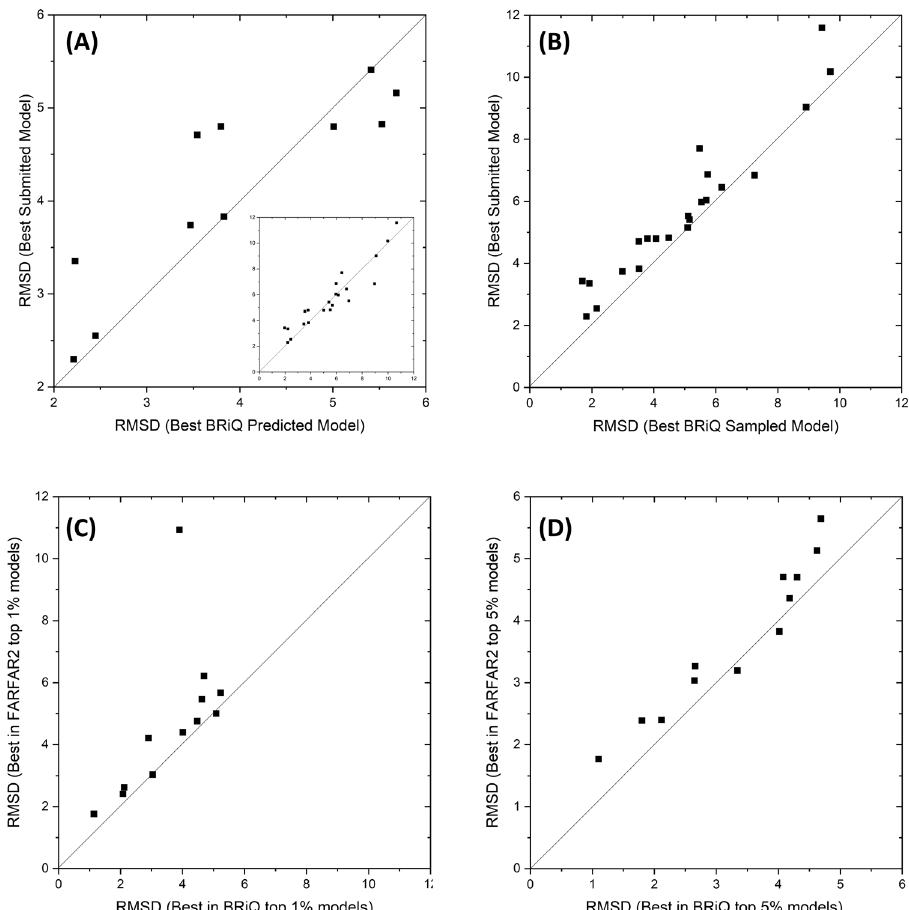
Fig. 4 Re fi nement of RNA puzzle models and FARFAR2 models by BRiQ. BRiQ re fi nement achieves consistent improvement over the best-submitted models for RNA puzzles containing model structures with RMSD <4 Å ( A ), over all RNA puzzles in conformational sampling ( B ), over FARFAR2 models for 10 out of 12 RNA puzzles in top 1% ( C ) and top 5% ( D ) predicted